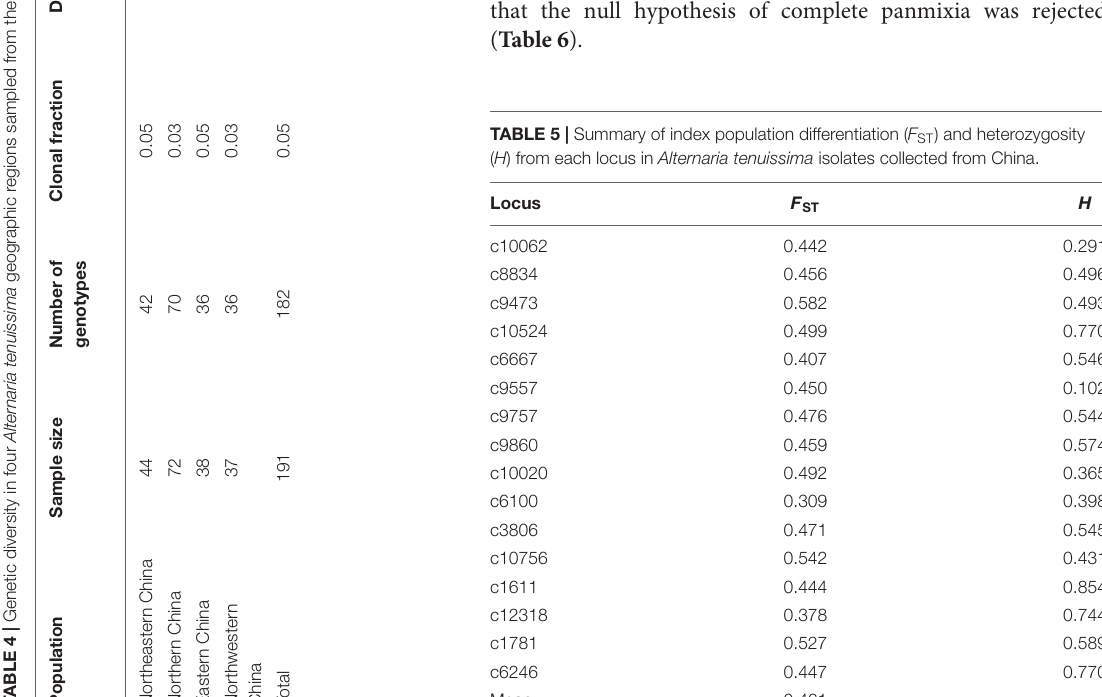
In an analysis of multilocus gametic disequilibrium, two measures of association, linkage disequilibrium ( I A ) and proportion of compatible pairs of loci ( r d ), were found to sample (all four geographic regions combined), indicating